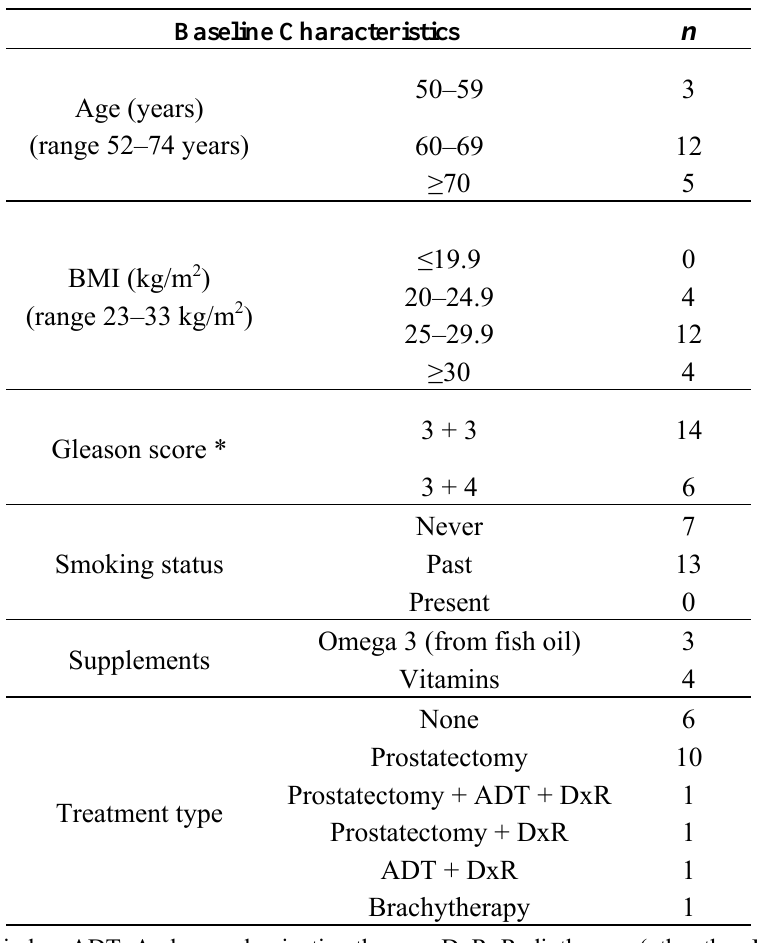
Table 1. Baseline characteristics of the study